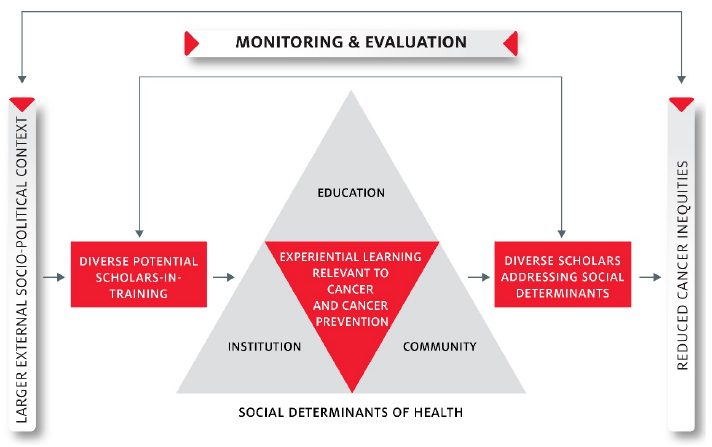
Figure 1. UHAND Program’s Conceptual